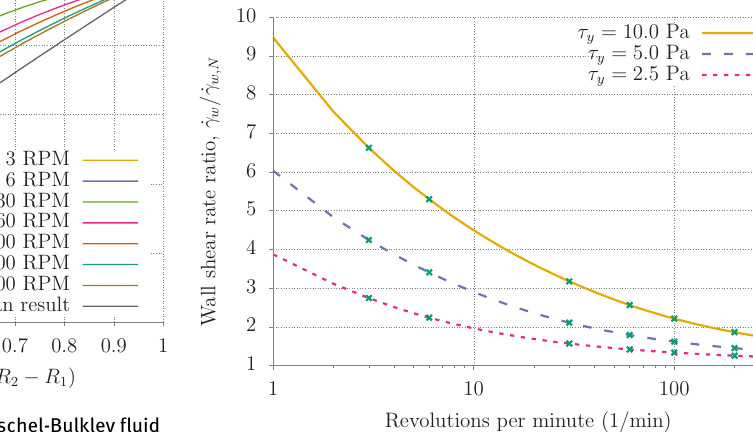
Figure 5: Same as Figure 4, but with k = 0.1 Pa · s n , n = 0.5 and varying τ y